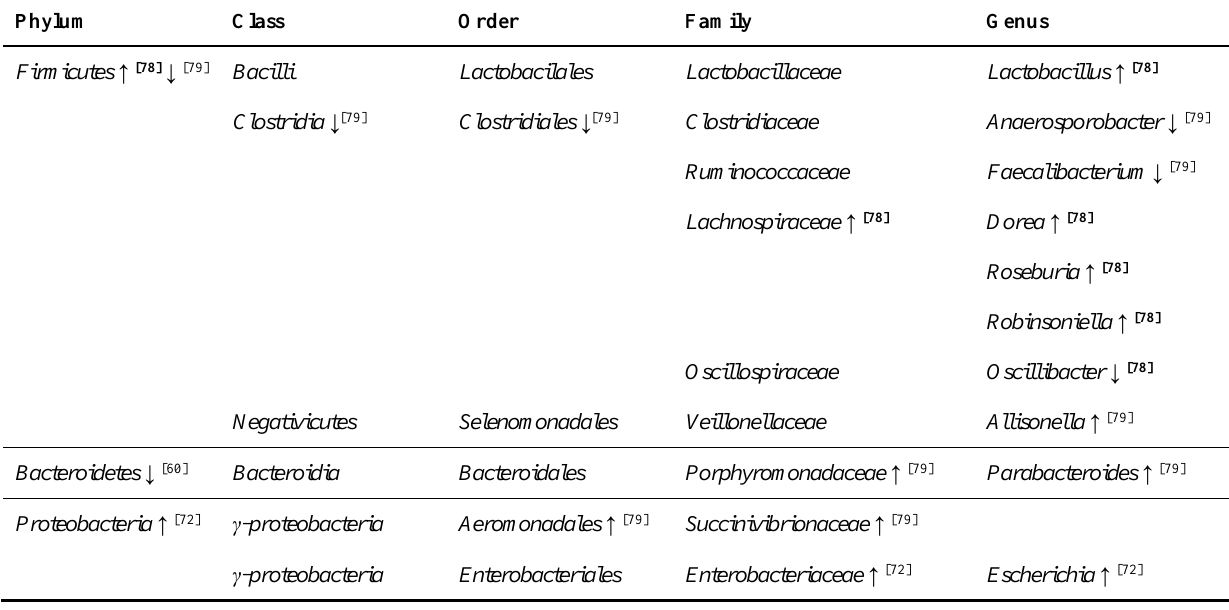
Table 3. Changes in intestinal microbiota associated with clinical studies on ΝΑFLD (in bold) and